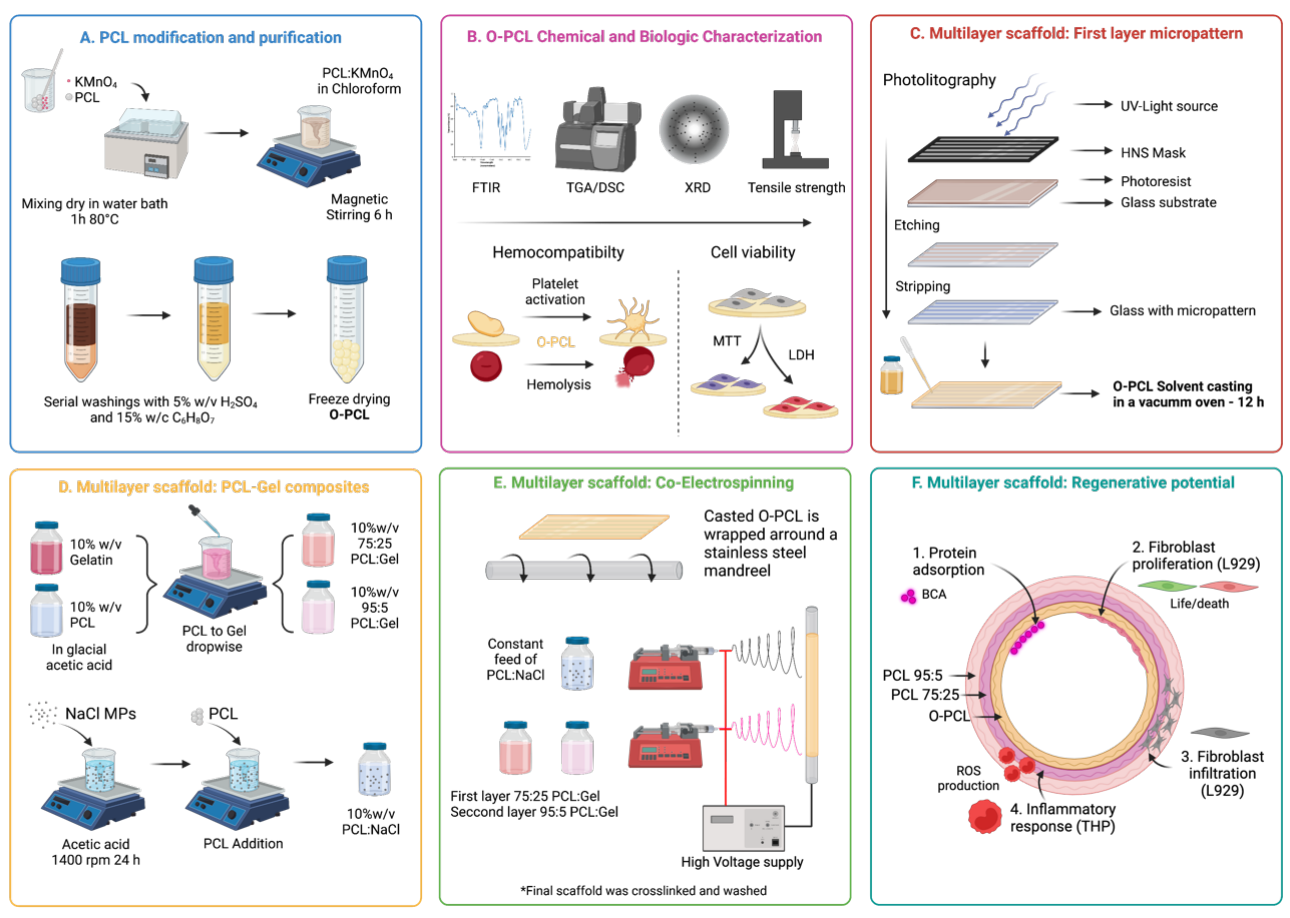
Figure 1. Schematic representation of the workflow for the fabrication of a tri-layer PCL-based scaffold with a physicochemical gradient of gelatin. ( A ) PCL oxidation with KMnO 4 . ( B ) Functionalization confirmation and biocompatibility assessment. ( C ) First layer fabrication by imprinting on a microgrooved mold manufactured via photolithography. ( D ) PCL:gelatin blending via a novel single-desolvation-based method. ( E ) Electrospinning of PCL:gelatin blends for the manufacture of the second and third layers. ( F ) Cellular and bioactive response of the multilayer scaffold via protein estimating adsorption capacity, cell viability, F-Actin staining and intracellular ROS levels.